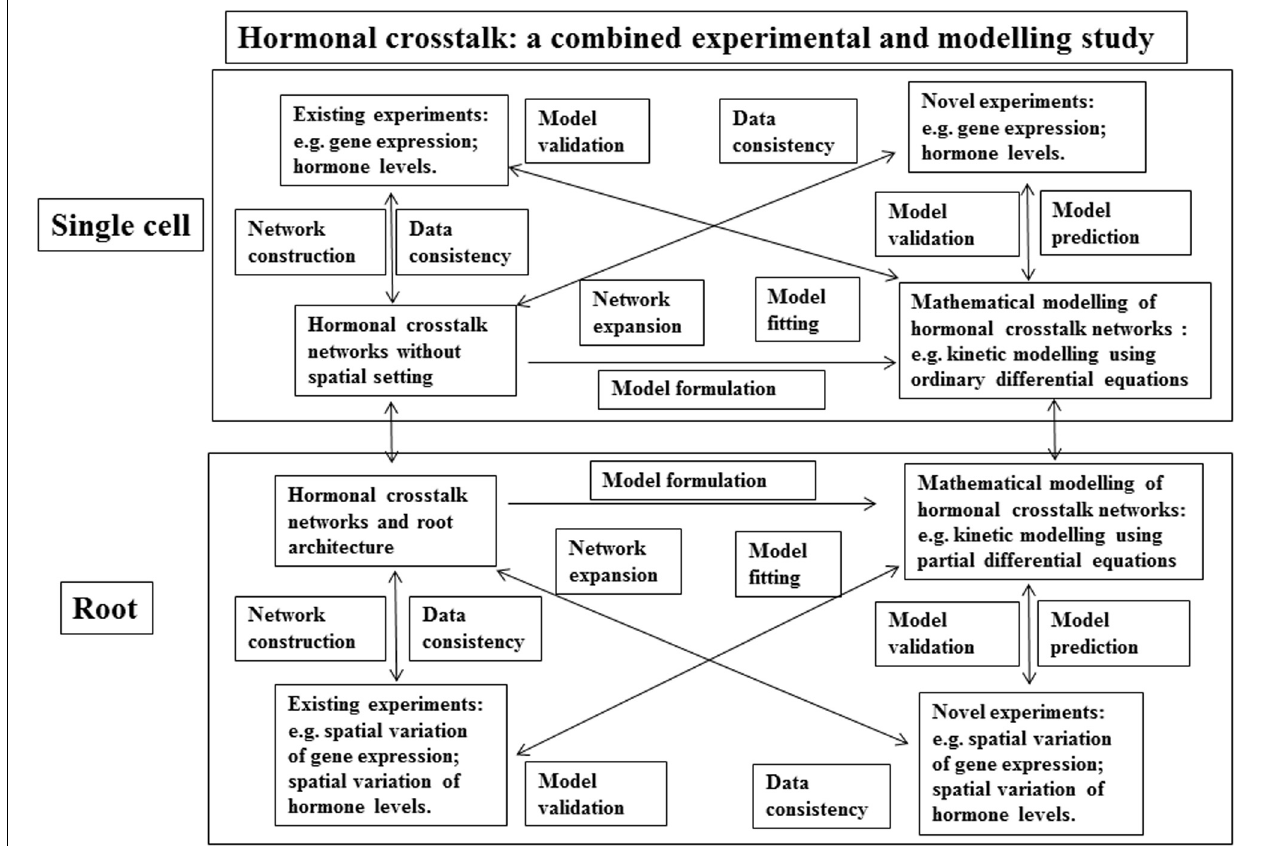
FIGURE 3 | A schematic description of a methodology for a combined experimental and modeling study on hormonal crosstalk in root development. Upper panel: Hormonal crosstalk networks are constructed using existing experimental data. The networks are used to check the consistency of existing experimental data and they are also used to formulate mathematical models such as models described using ordinary differential equations. The mathematical models are validated using the existing